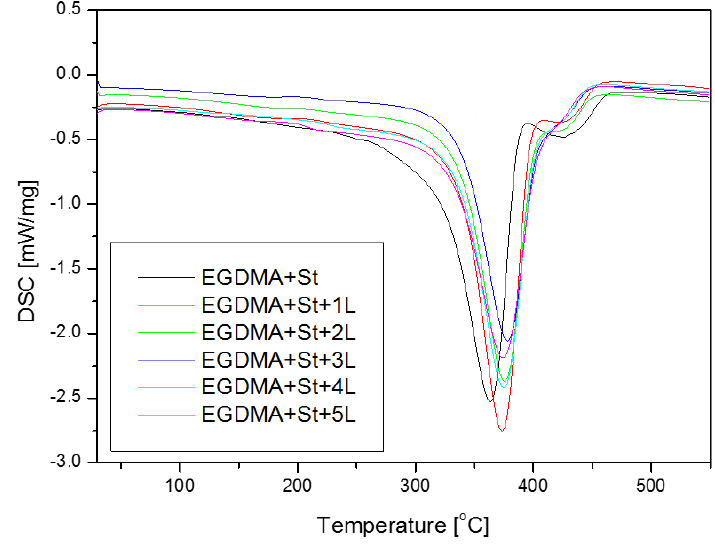
Figure 8. Di ff erential scanning calorimetry curves of Figure 8. Differential scanning calorimetry curves of copolymers.